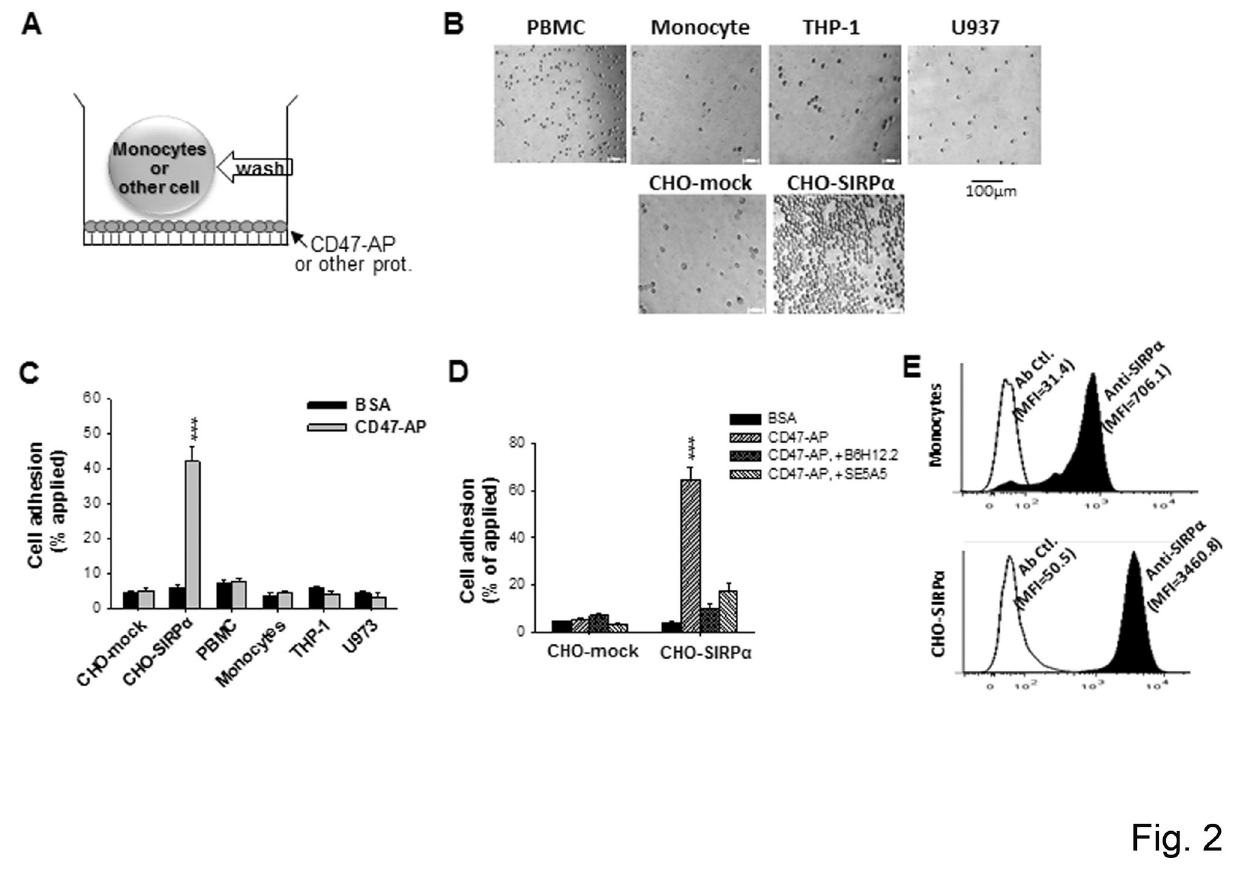
Figure 2. SIRPα in naïve monocytes do not mediate cell adhesion to immobilized CD47. A) Schematic depiction of the cell adhesion assay. B) Adhesion of different cells to immobilized CD47-AP. Cell suspensions were incubated with CD47-AP or BSA (ctl.) for 30 min (25°C), followed by washing. C) Percentage of cell adhesion to CD47-AP versus BSA. D) Control adhesion performed using CHO cells with or without SIRPα transfection (CHO-mock and CHO-SIRPα, respectively), and in the presence or absence of inhibitory anti-SIRPα (SE5A5) and anti-CD47 (B6H12.2) mAbs (20 μg/ml for each). The data are expressed as the means ± SE and represent three independent experiments with triplicate wells per cell type. ***, P <0.001. E) FACS analyses of SIRPα on the cell surfaces of peripheral monocytes and CHO-SIRPα